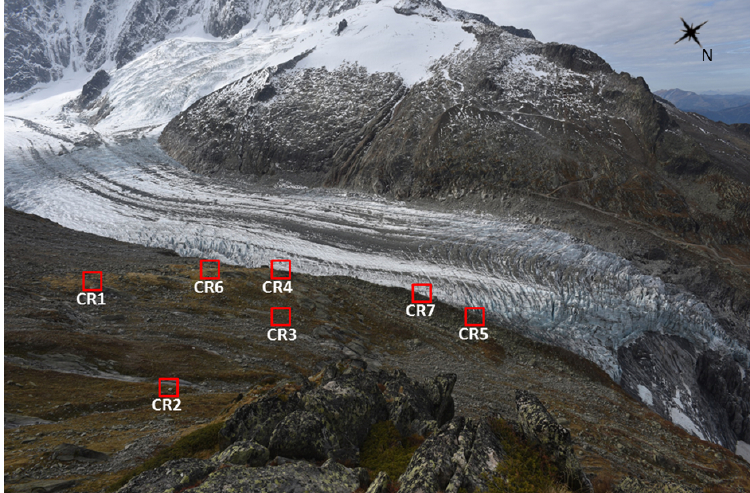
Figure 12. Photograph from one of the two cameras (Latitude: 45.97170570, longitude: 6.97575317, altitude: 2611.78) overlooking the study area (2017/09/29). Red squares: CR